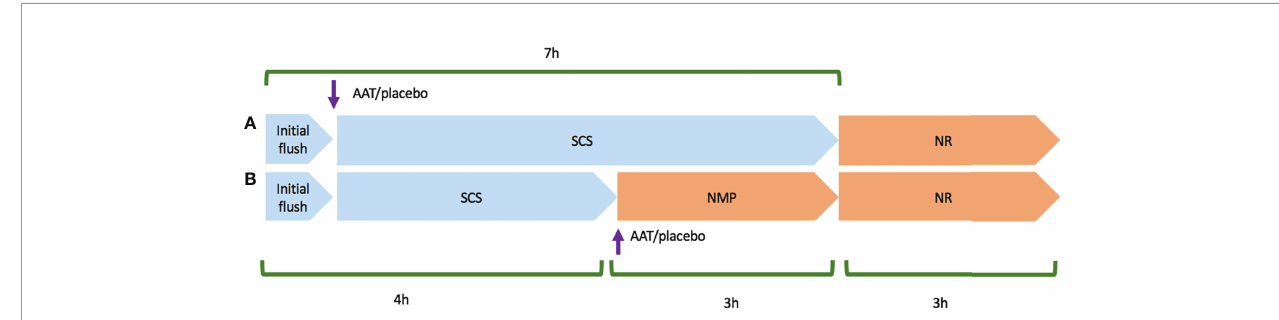
FIGURE 1 | Schematic planning of model 1 and model 2 experiments. Cold ischaemia time started upon the initial fl ush using Soltran. (A) Represents model 1 experiment that Alpha-1 antitrypsin (AAT) or placebo was added in the second fl ush, and then kidney pairs were stored in static cold storage (SCS) in a mixture of Soltran + Alpha-1 antitrypsin (AAT) or placebo. (B) Represents model 2 experiment that following retrieval, kidney pairs were transferred to the lab in cold storage, and then AAT or placebo was added to NMP circuits once both normothermic machine perfusion preservation (NMP) circuits were primed. Both models were followed and completed by 3-h normothermic reperfusion with whole blood